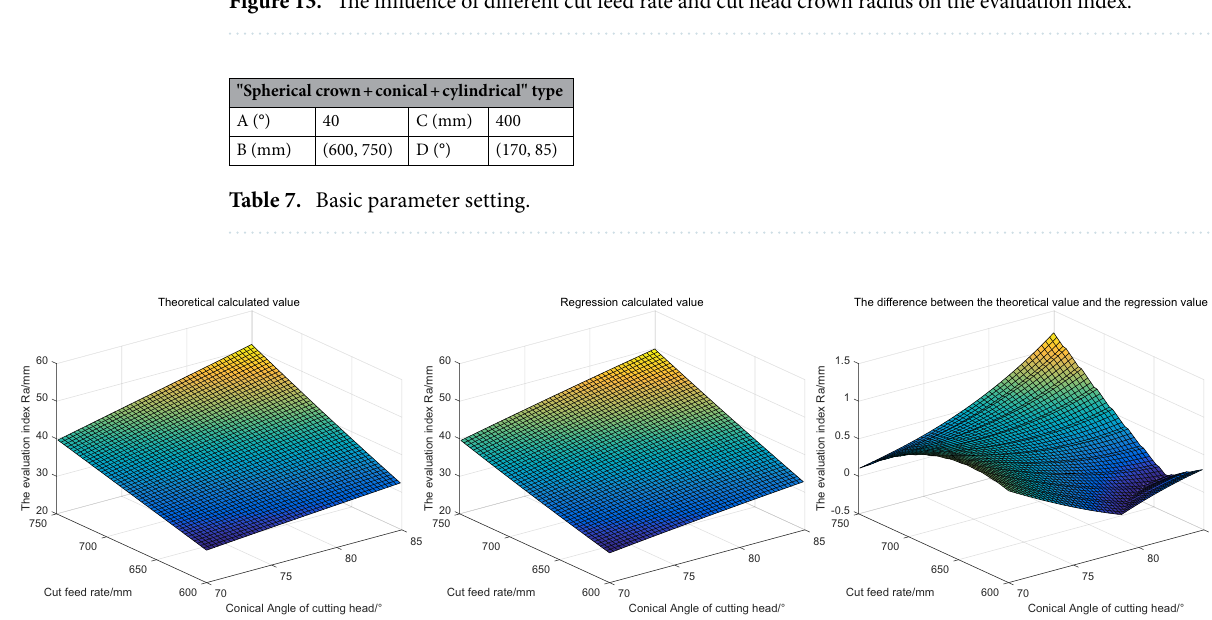
Figure 14. The influence of different cutting feed rate and conical Angle of cutting head on evaluation